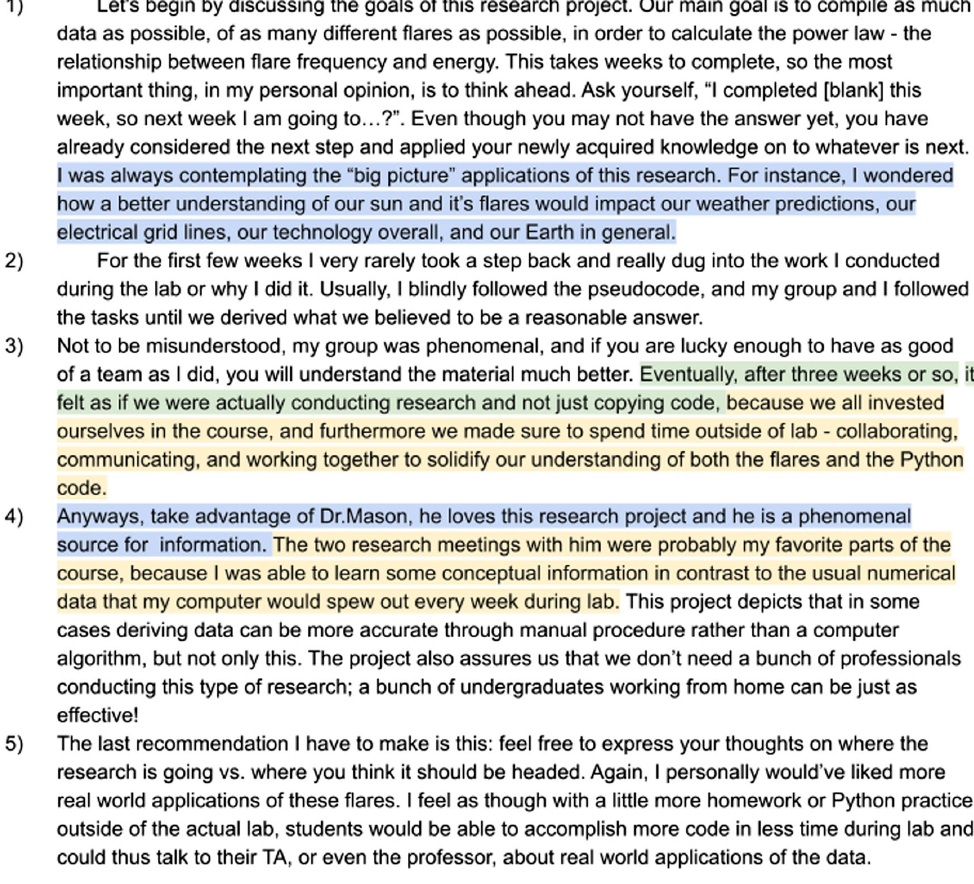
FIG. 5. Student 4 ’ s response to the memo assignment. Green highlighting corresponds to a direct authenticity code, blue highlighting corresponds to an indirect authenticity code, and yellow highlighting corresponds to a research components